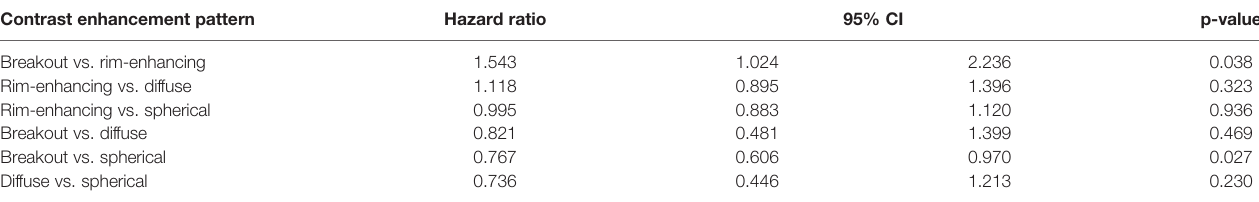
TABLE 2 | All pairwise comparison of overall survival according to the contrast enhancement pattern on magnetic resonance images. Contrast enhancement